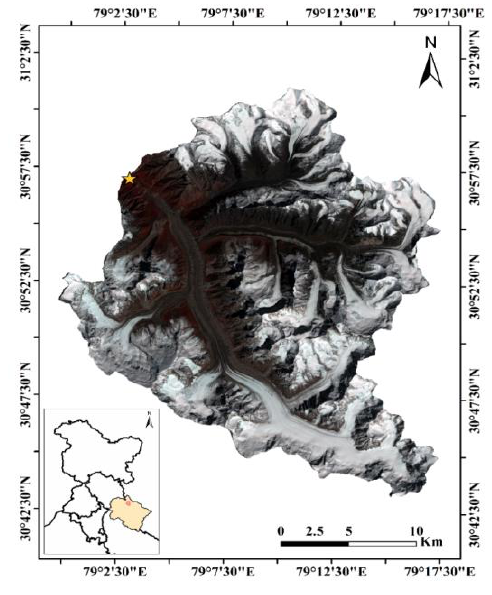
Figure 1. Satellite image of the study